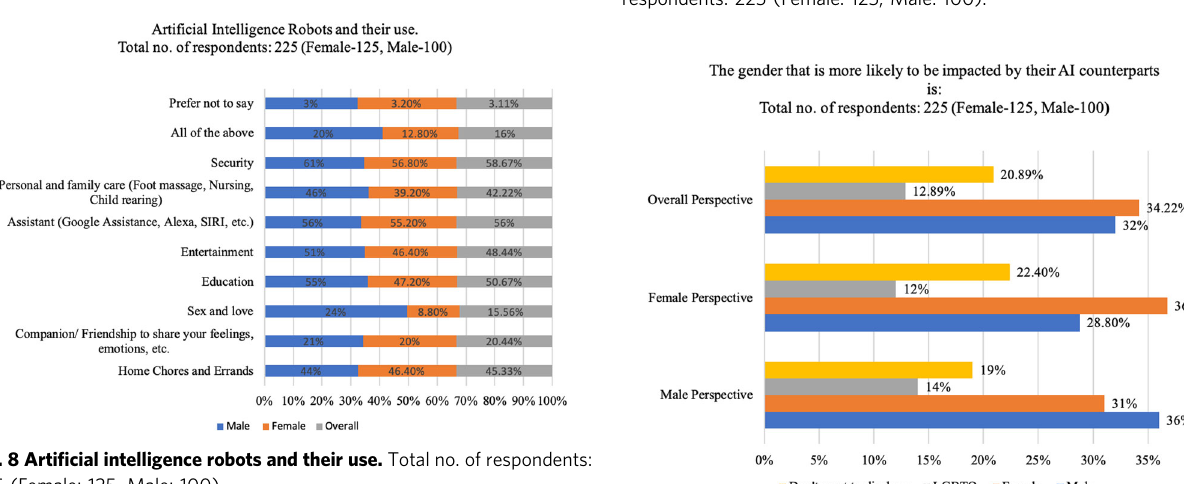
Fig. 10 AI robots may unduly favor one gender over the other. Total no. of respondents: 225 (Female: 125, Male: 100).